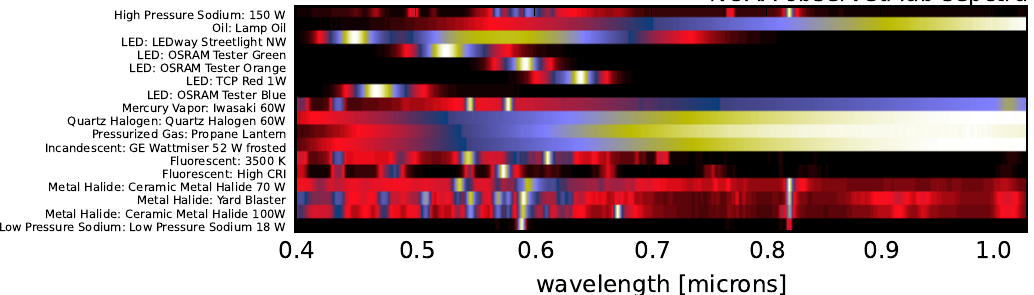
Figure 9. The result of pruning the spectra shown in Figure 7 to only include templates that have low co-variance. In addition, the templates have been interpolated onto the wavelengths of our VNIR instrument (see Section